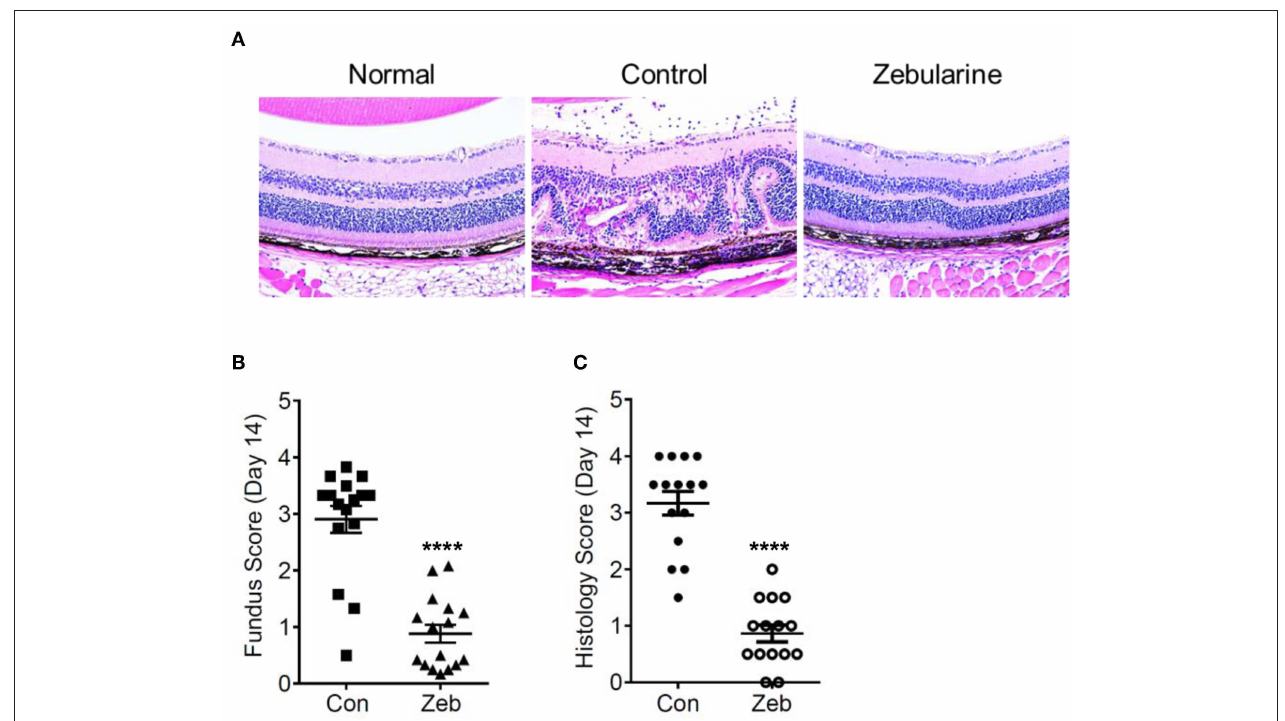
FIGURE 7 | Histological analyses of the retinal tissues from EAU mice treated with zebularine or vehicle on Day 14 post immunization. (A) Representative HE histological sections of EAU mice treated with zebularine or vehicle. The fundus scores and histology scores of EAU mice treated with zebularine ( N = 16) or vehicle ( N = 15) on Day 14 are shown in (B,C) . Means ± SD are shown **** P <